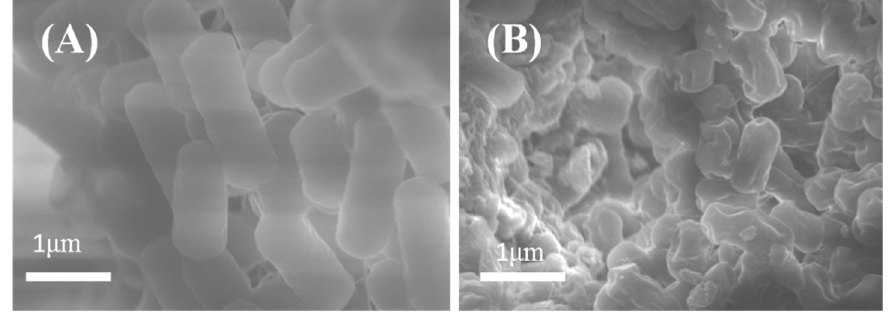
Figure 8. ( A , B ) SEM images of E. coli without treatment and with treatment with 1